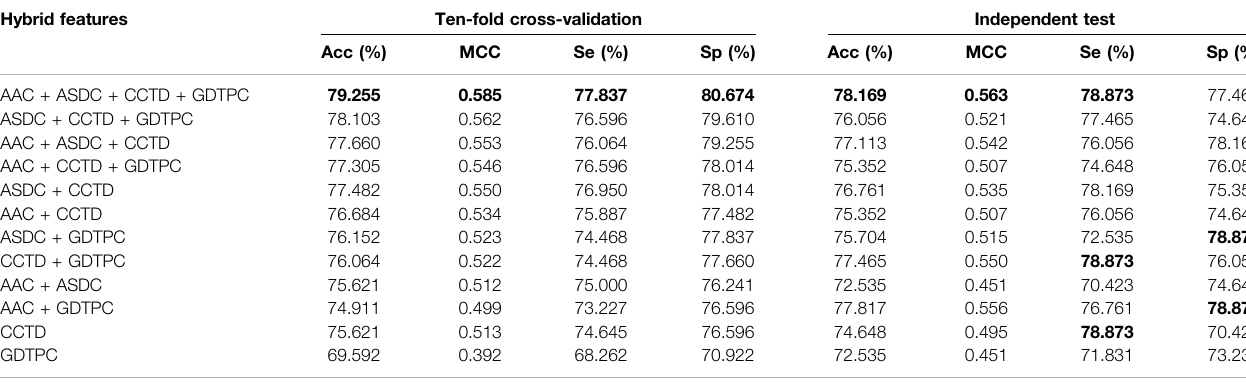
TABLE 2 | The classi fi cation results of different hybrid feature combinations detected by the LGBM classi fi er. Hybrid features